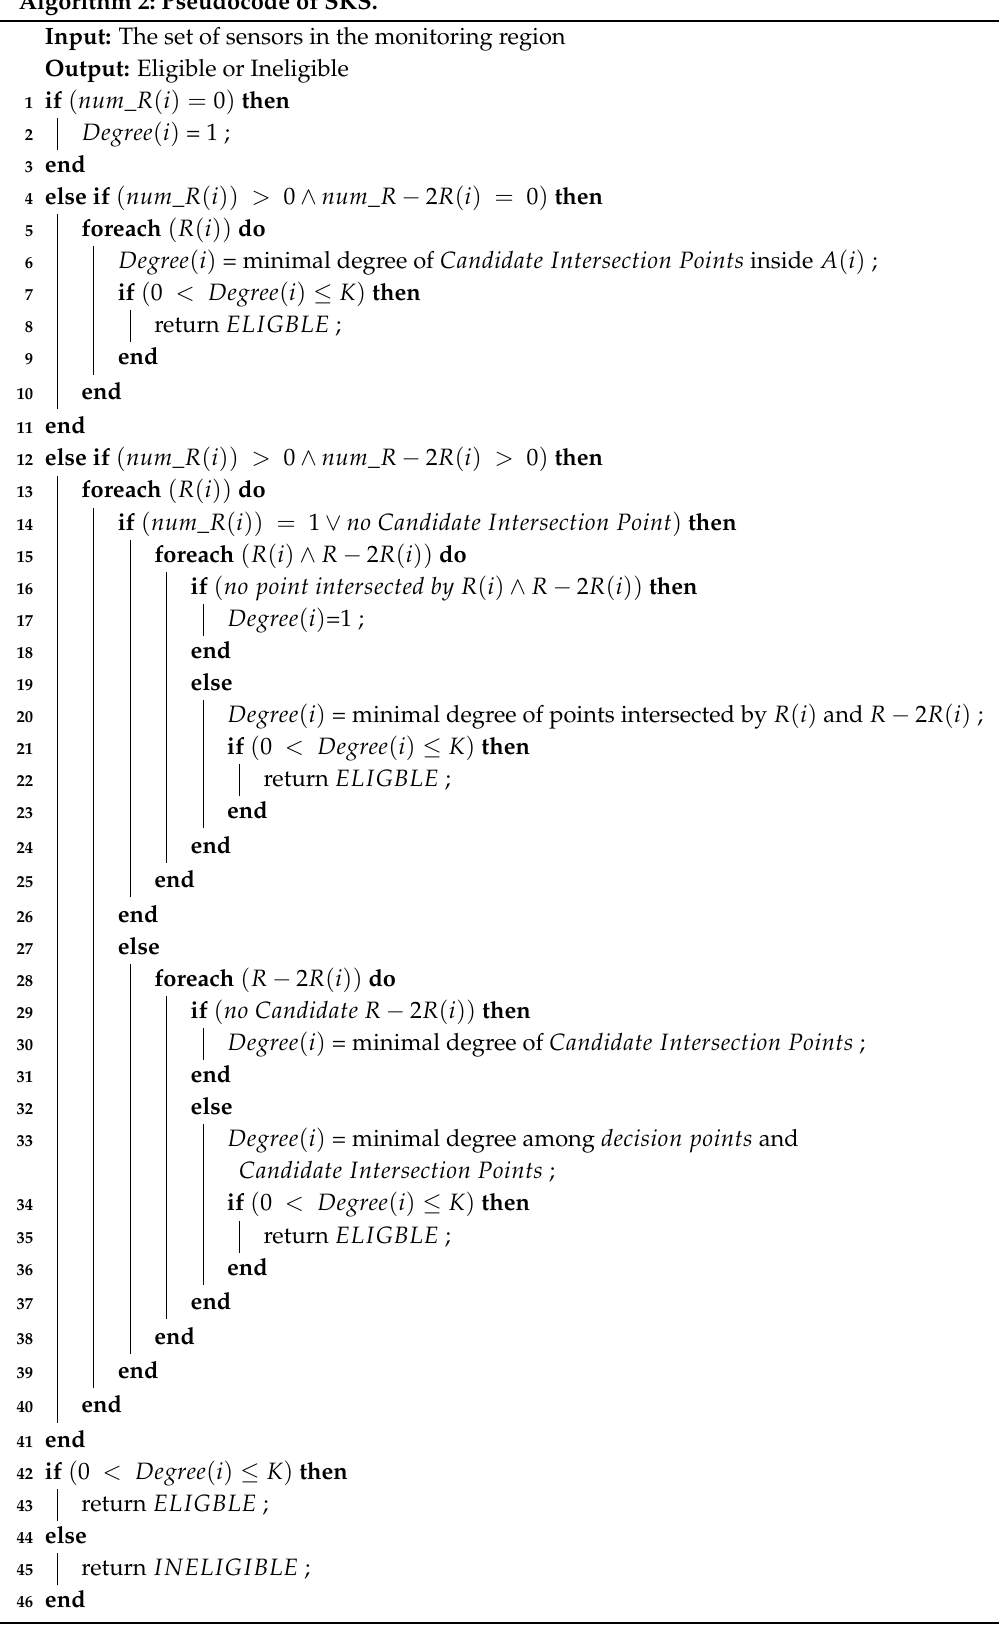
Algorithm 2: Pseudocode of